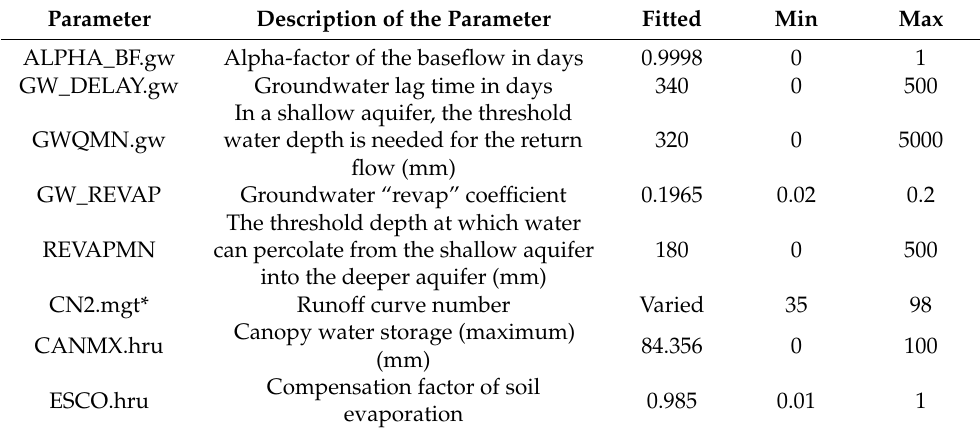
Table 7. SWAT model calibrated parameters (Deraniyagala sub-basin). Parameter Description of the Parameter Fitted ALPHA_BF.gw Alpha-factor of the baseflow in days In a shallow aquifer, the threshold